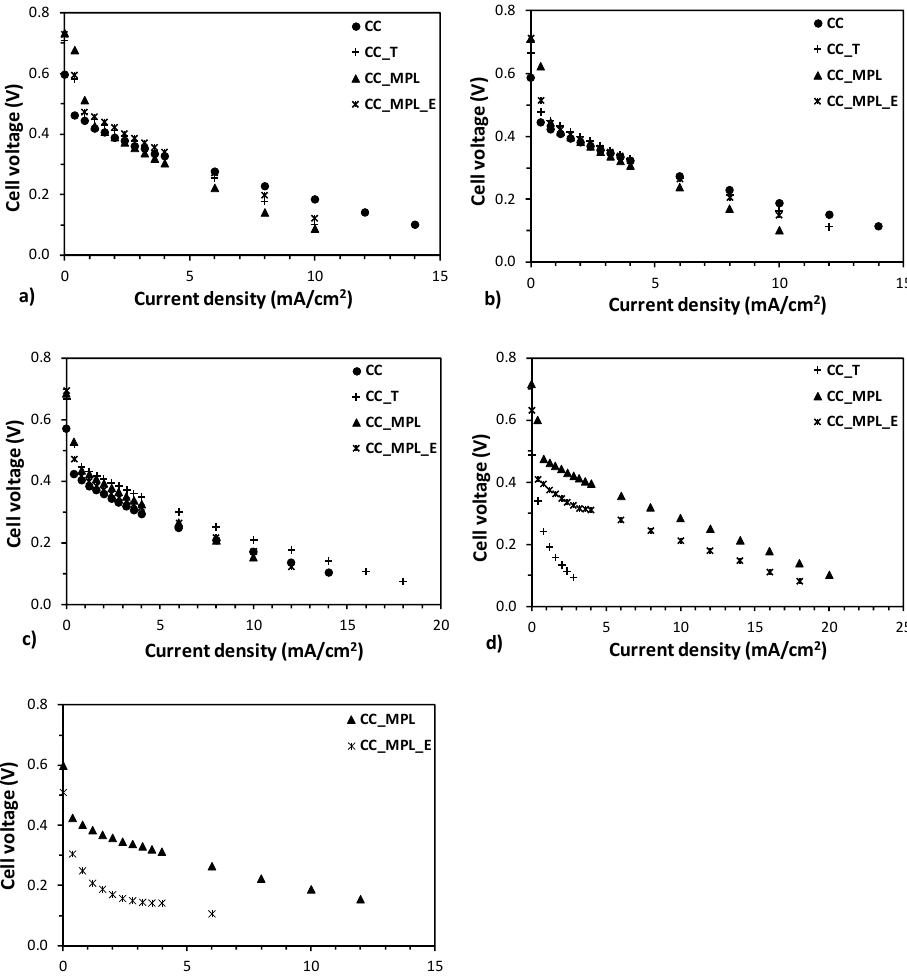
Figure 4. E ff ect of using carbon cloth with di ff erent properties as ADL on the cell performance; methanol Figure 4. Effect of using carbon cloth with different properties as ADL on the cell performance; concentrations: ( a ) 1 M, ( b ) 2 M, ( c ) 3 M, ( d ) 5 M, and ( e ) 7 methanol concentrations: ( a ) 1 M, ( b ) 2 M, ( c ) 3 M, ( d ) 5 M, and ( e ) 7 M.